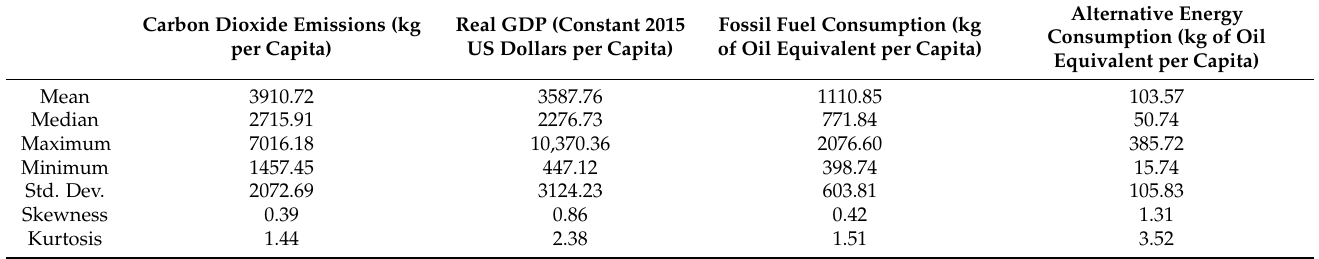
Table 1. Descriptive statistics of